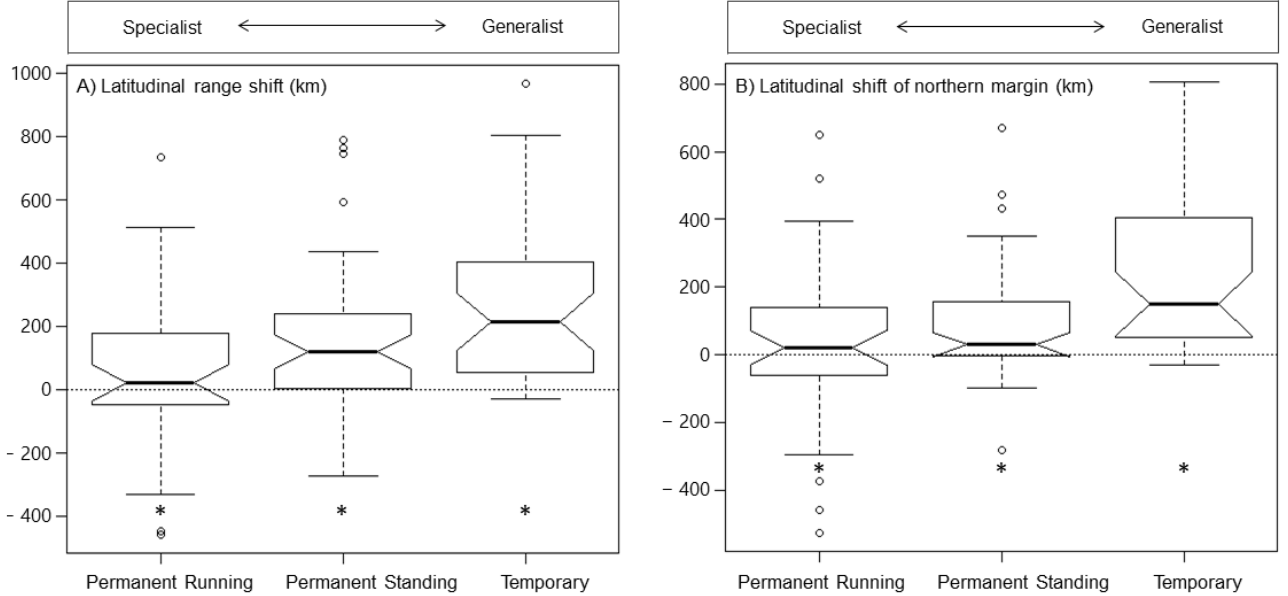
Figure 4. Range shift in European dragonfly (Odonata) species adapted to permanent running (perennial lotic) water, permanent standing (perennial lentic) water, or temporary (running and standing) water habitats between 1988 and 2010 with a shift in latitudinal range expressed as the change in latitudinal extent of distributional range and a shift in northern range border expressed as the change in the maximum of distributional range latitude separated by habitat utilization. Range expansion and contraction is expressed with positive and negative values, respectively. The box-and- whisker plots illustrate the spread and skewness of the data through their quartiles. The whiskers extending from the box show data variability outside the upper and lower quartiles. Outlier points that differ significantly from the rest of the dataset are plotted as individual points (empty circles) beyond the whiskers. The box notches narrow around the median (thick black middle line) and offer a visual guide of the significance of the difference of medians; if the notches of two boxes do not overlap, this will provide evidence of a statistically significant difference between the medians. Significant variables at α = 0.05 in the analysis of a shift in latitudinal range and northern range border of the three unmatched test groups —permanent running water, permanent standing water, and temporary (running or standing) water—are indicated with *. Top scale represents a gradient going from habitat specialist with a narrow niche breadth to habitat generalist with a broad niche breadth.